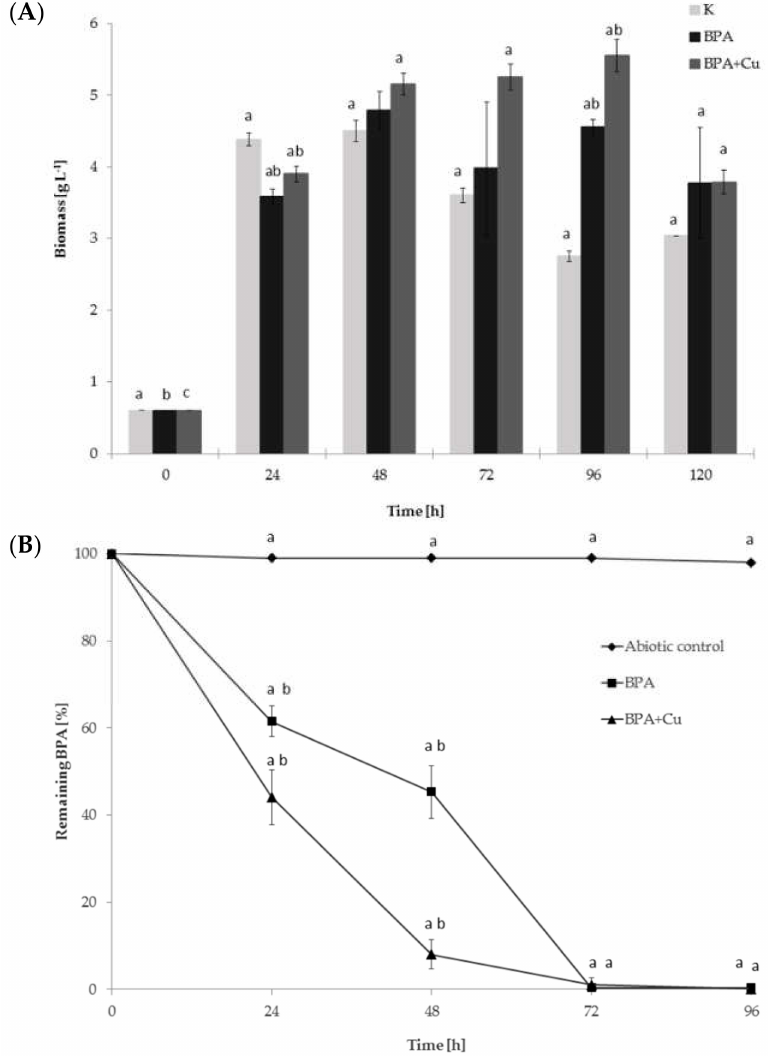
Figure 1. ( A ) The biomass and ( B ) kinetics of BPA elimination in M. roridum cultures incubated with the addition of BPA at a concentration of 50 mg · L − 1 on Czapek-Dox III medium. Letters represent values with statistically significant differences determined with a one-way ANOVA followed by the Tukey test ( α = 0.05) for different